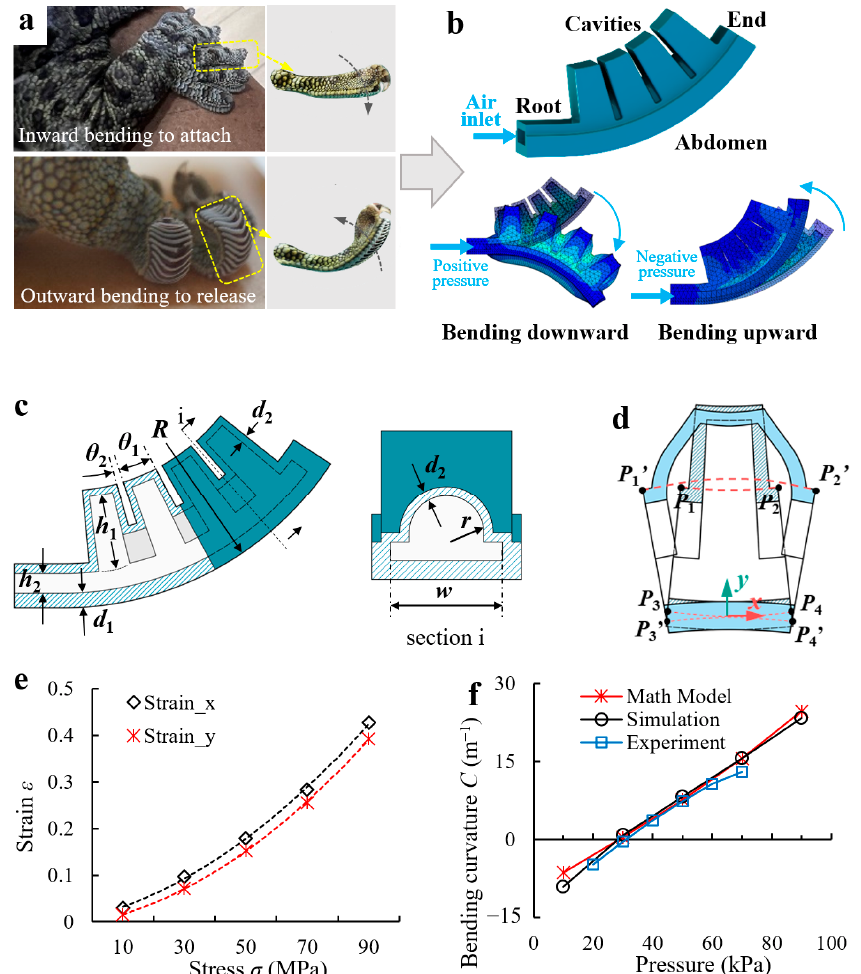
Figure 1. ( a ) Reversible adhesive behavior of the gecko toe. ( b ) Gecko-inspired fluidic-driven elastic actuator acting as the supporting/driving layer of the bio-toe and its upward/downward bending deformation when driven by positive/negative pressure. ( c ) Schematic of the elastic actuator. ( d ) Illustration of the mathematical model of the bending deformation. ( e ) Fitting functions of the strain–stress relationship for the elastic actuator on the x and y axis. ( f ) Bending curvatures of the elastic actuator versus pressure from the mathematical model, simulation, and experimental results.